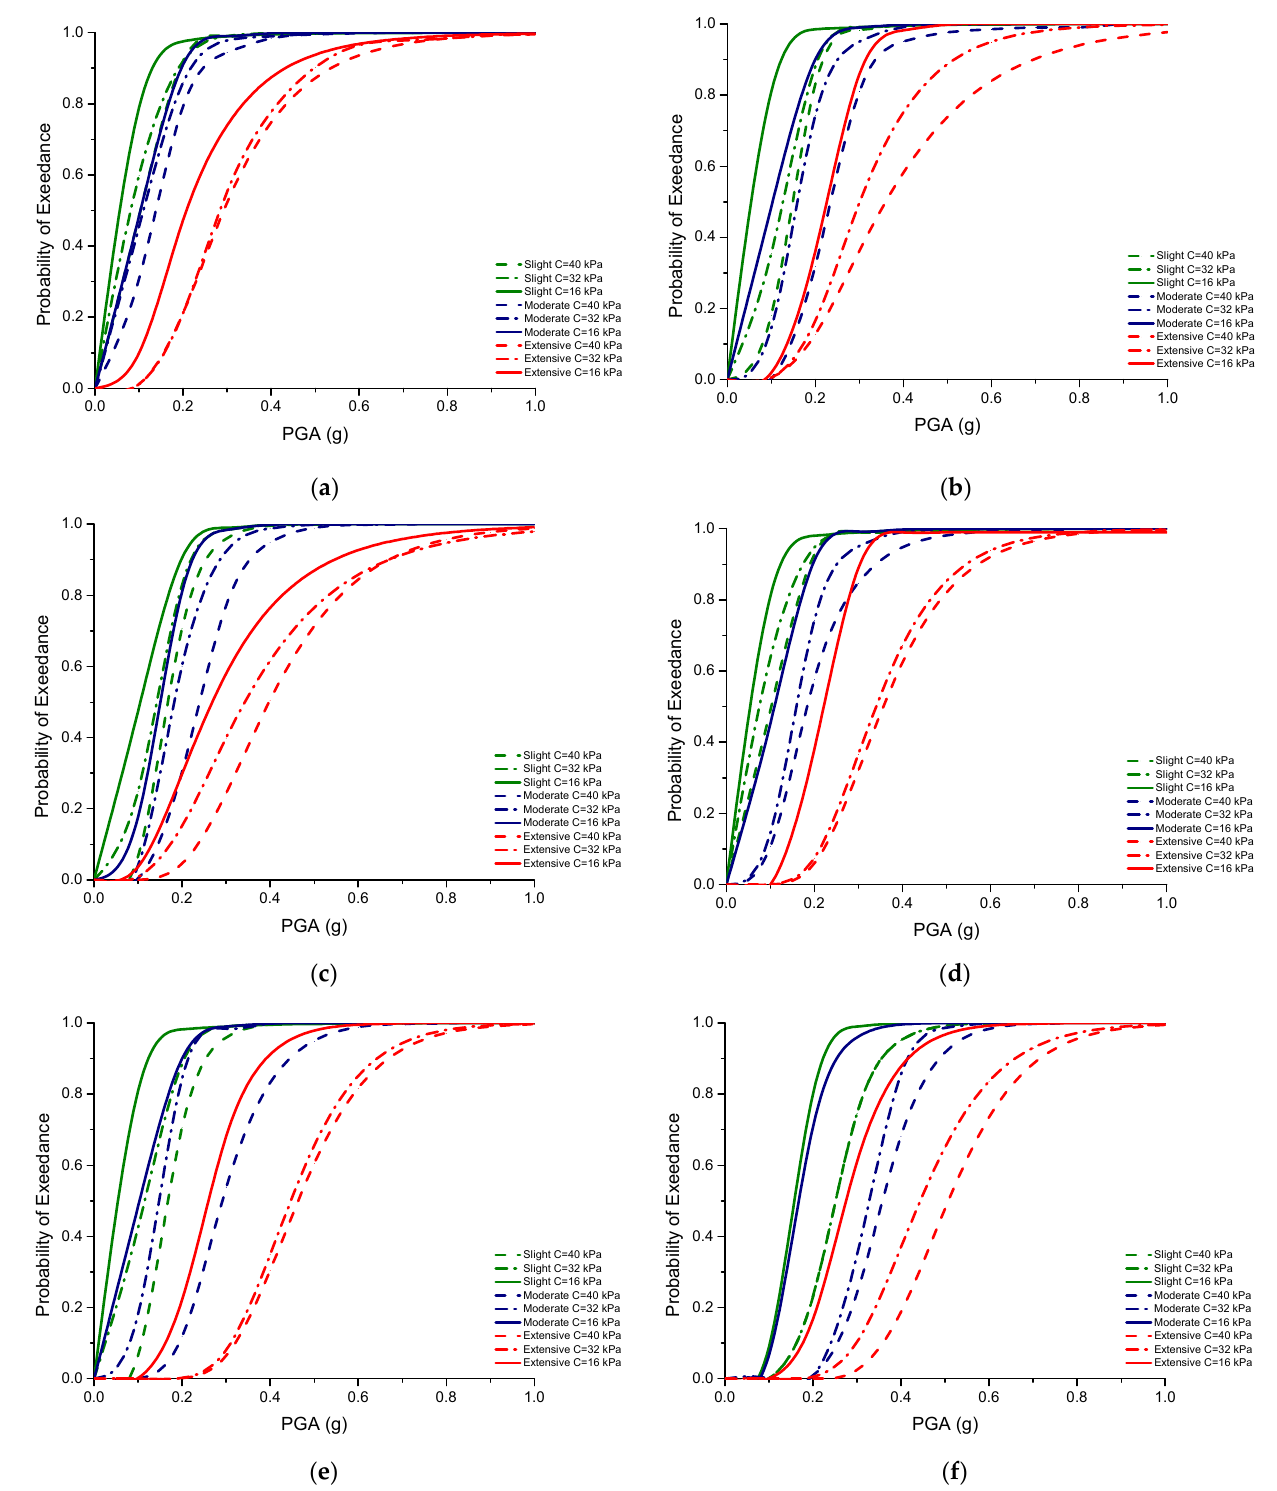
Figure 7. Fragility curves of the embankments due to cohesion variation and ϕ = 30°, ( a ) E1, near-field, ( b ) E2, near-field, ( c ) E3, near-field ( d ), E1, far-field, ( e ) E2, far-field, ( f ) E3, far-field. Table 8. Fragility curve parameters considering the different cohesion of the soil properties sub- jected to near-field and far-field earthquake ground motions.